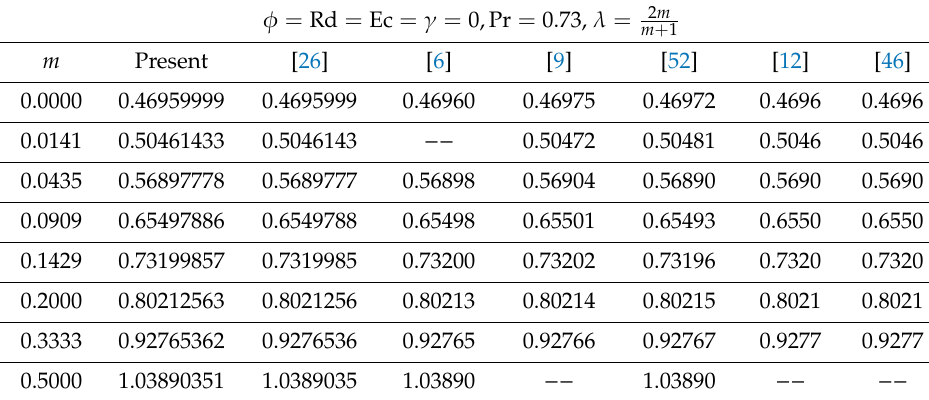
Table 2. Comparative analysis for 𝐹′′(0) .